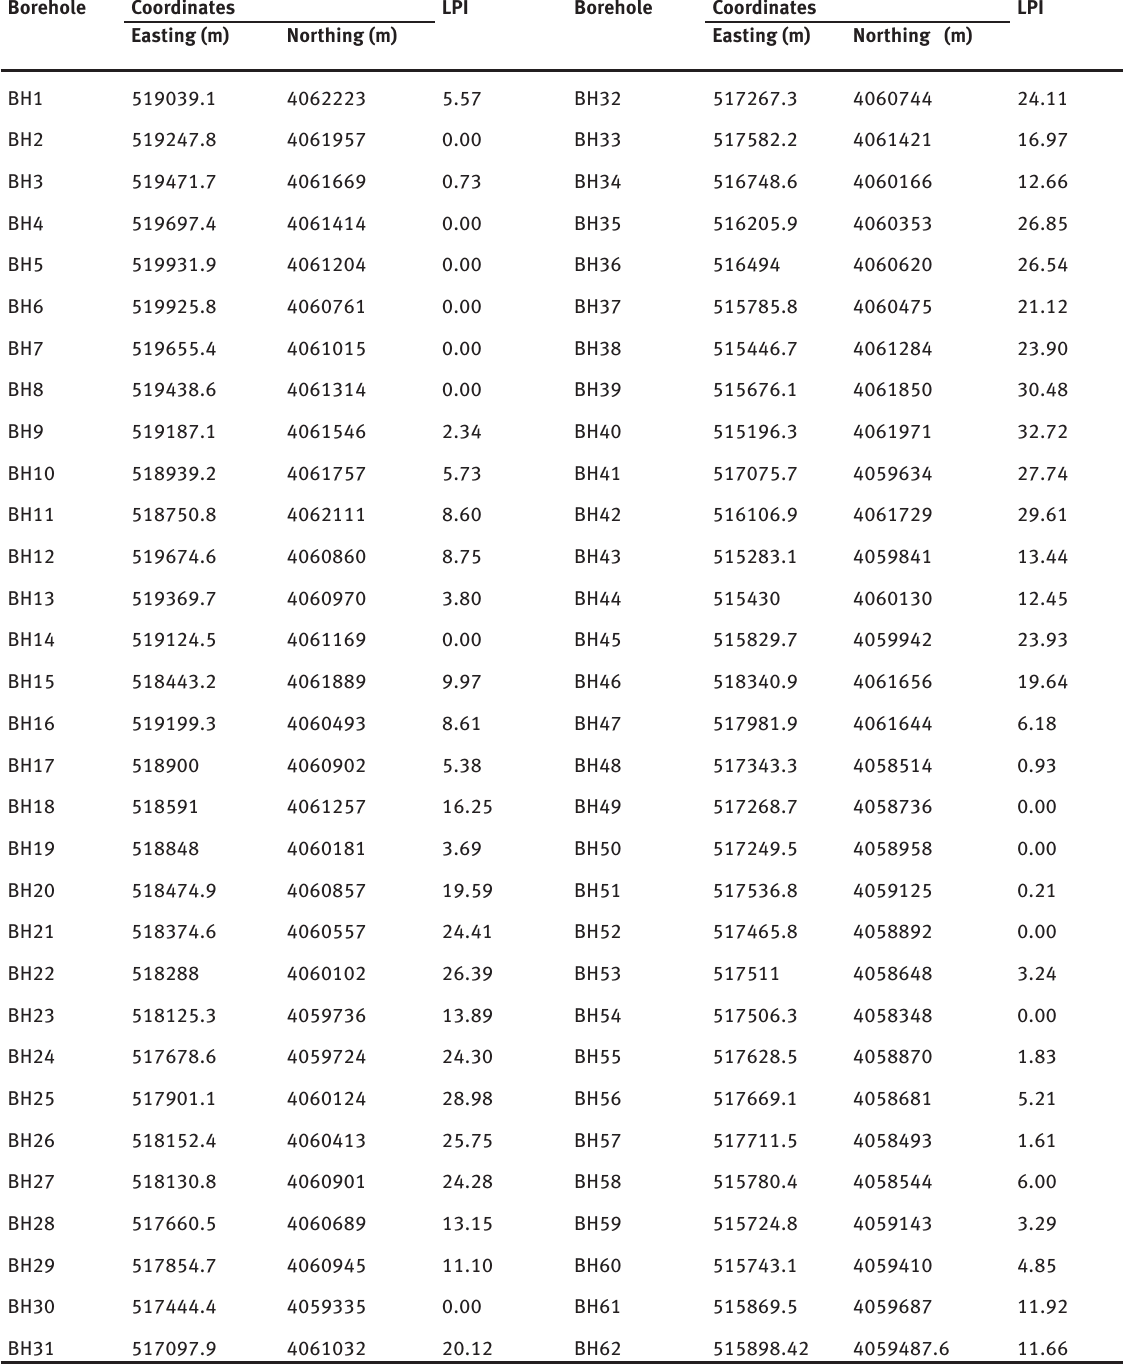
Table 2: Calculated values of liquefaction potential index (LPI).